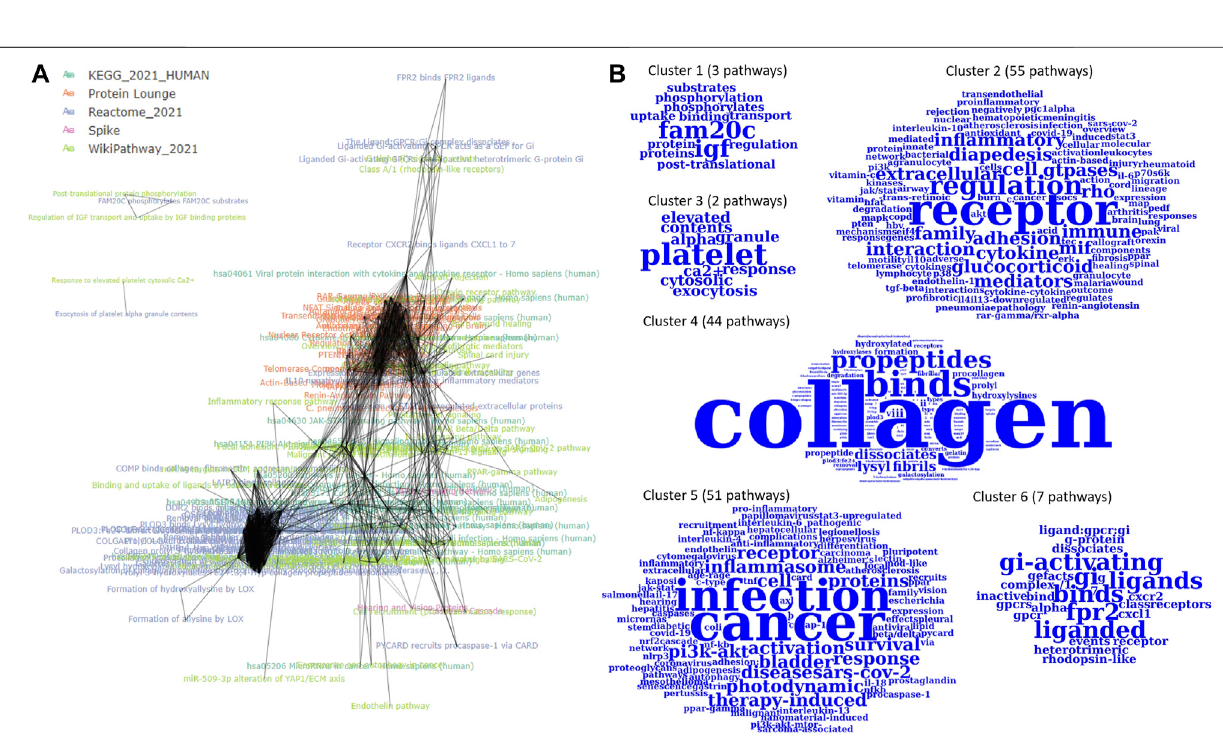
PAG-to-PAG network ( Figure 3 ). The extracted concepts reveal the general pathway functions in the clusters. Cluster 1 consists of 3 pathways with represented terms “ FAM20C ” protein